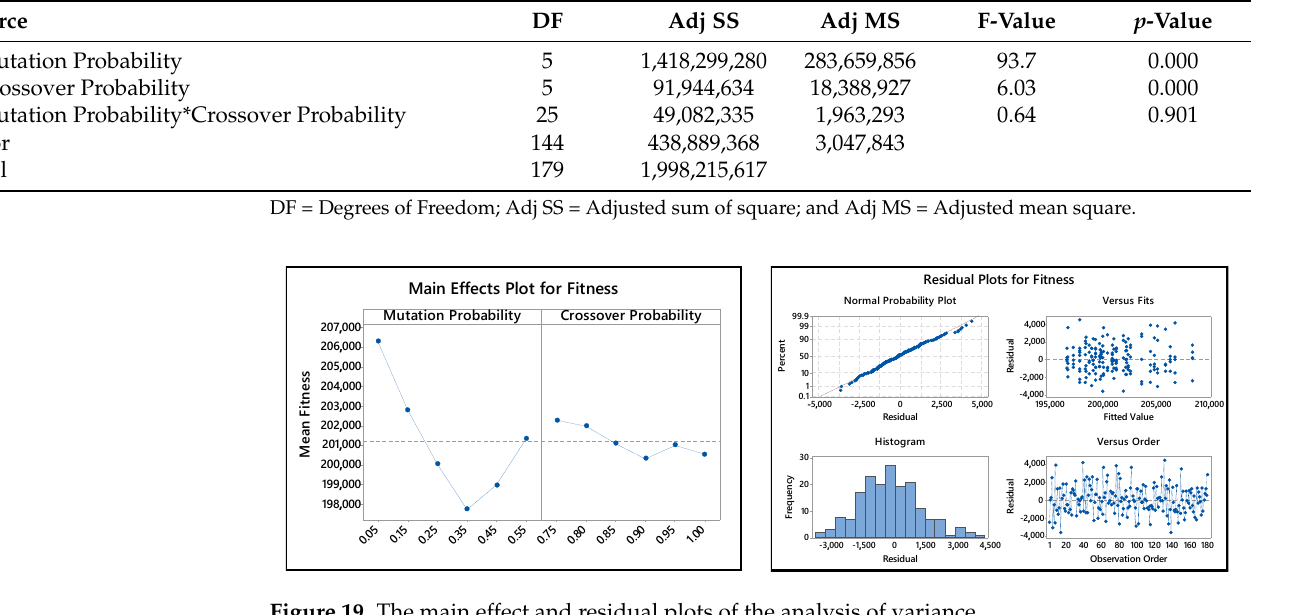
Figure 19. The main effect and residual plots of the analysis of